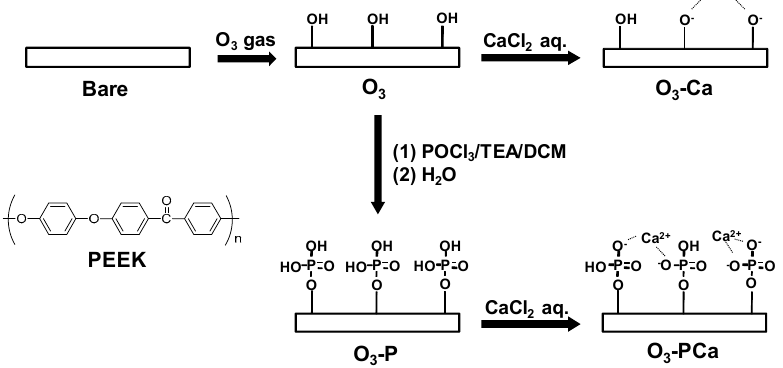
Figure 1. Schematic representation of the combined phosphate and calcium surface functionalization. POCl 3 : phosphoryl chloride, TEA: triethylamine, DCM: dichloromethane, PEEK: Poly(ether ether ketone).